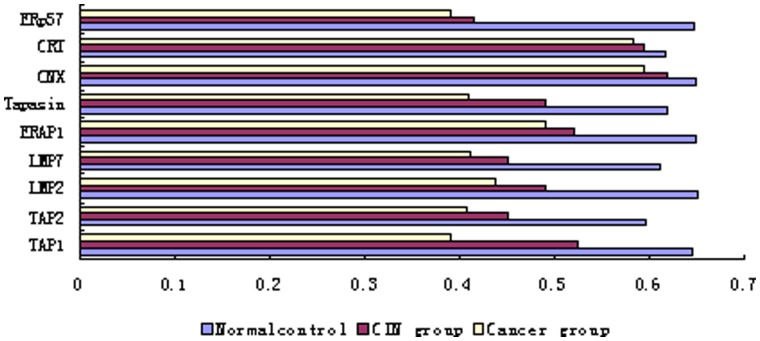
Down-regulation of APM genes during the progression of cervical lesions.Expression levels of the APM components (TAP-1, TAP-2, LMP2, LMP7, Tapasin, ERAP1, CNX, CRT and ERp57) were analyzed by Semi-quantitative RT-PCR in normal uterine cervix tissue, CIN and CSCC. Compared to the control, CIN and CSCC, mRNA levels were normalized to β-actin mRNA. The upper histogram has shown the expression levels of the APM components in in normal uterine cervix tissue, CIN and CSCC. The results of RT-PCR are represented as means ± SD from 15 controls, 30 CIN and 33 CSCC respectively. * P < 0.05.